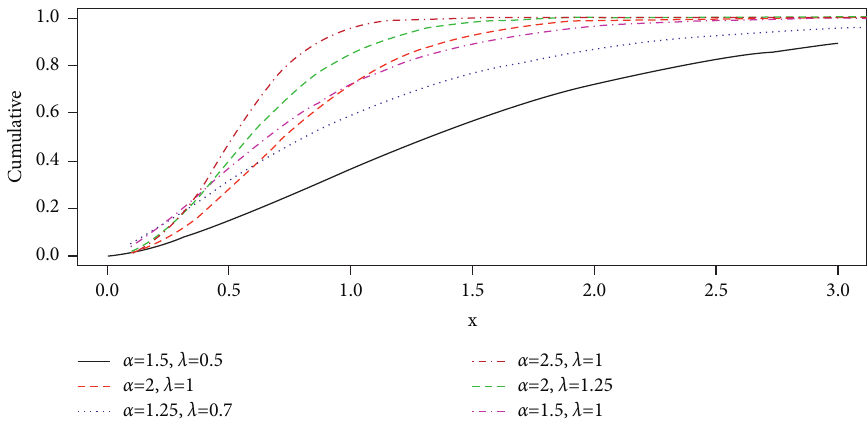
Figure 1: Visual representation of the cdf plots of the AT-W distribution for various parameter values.